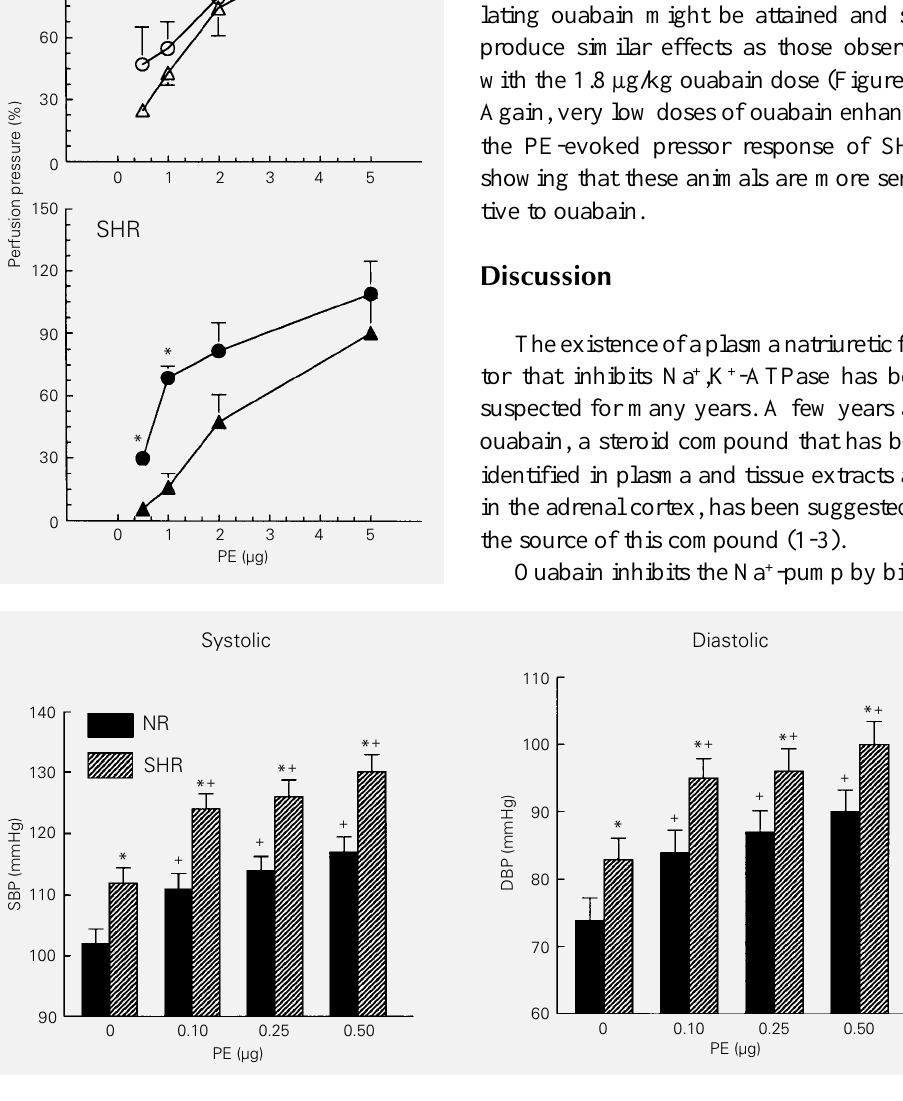
(ANOVA).Figure 2 - Effect of 10 nM oua- bain percent changes above baseline perfusion pressure on phenylephrine-induced pressor responses in isolated perfused rat tail vascular beds from hyper- tensive (SHR) and normotensive Wistar Kyoto (WKY) rats. Points represent means – SEM. *P<0.05 for comparison be- tween before (triangles) and af- ter (circles) 10 nM ouabain treat- ment